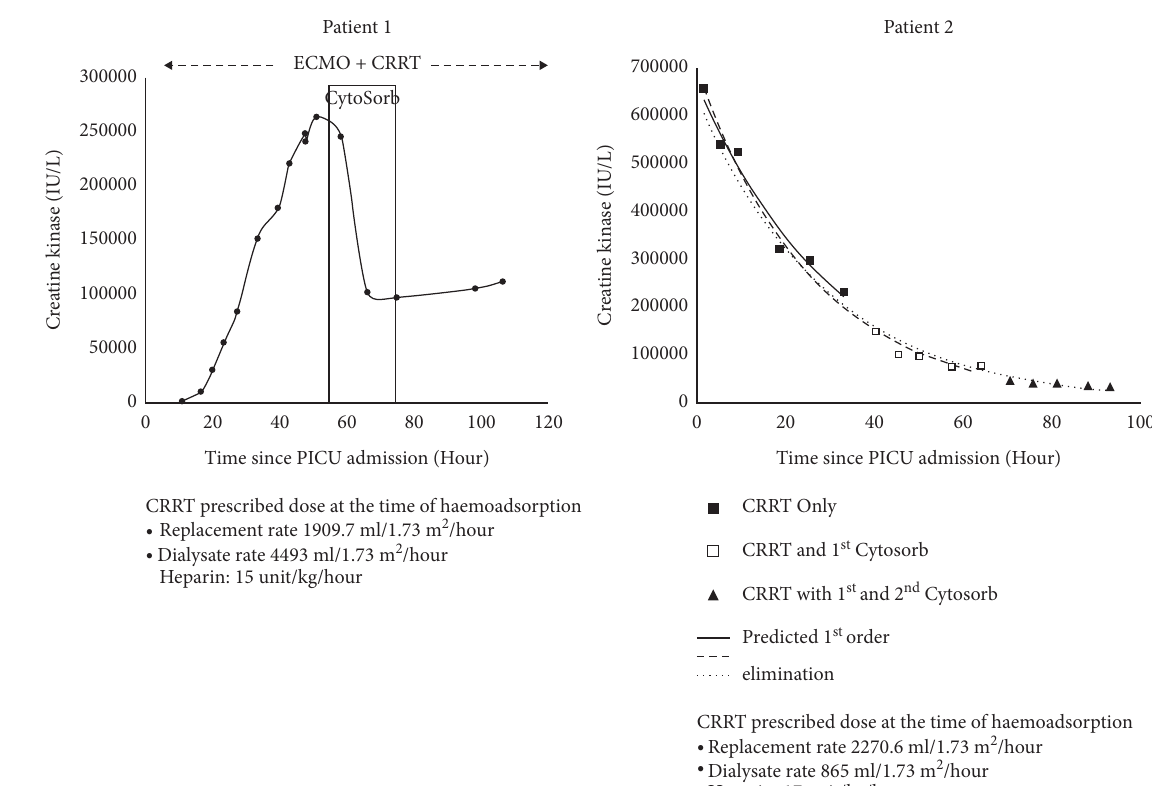
Figure 1: Trend of creatine kinase levels during CRRTand haemoadsorption treatment. For patient 2, the serum creatine kinase level after admission was plotted against time. A trend line using log scale was created for three different sets of data for first-order elimination prediction (black square represents data from CRRTonly, white square represents data from CRRTplus 1st column of CytoSorb, and black triangle represents data from CRRT plus 1st and 2nd columns of CytoSorb). A slightly faster rate of decline could be observed from data using both CRRT and